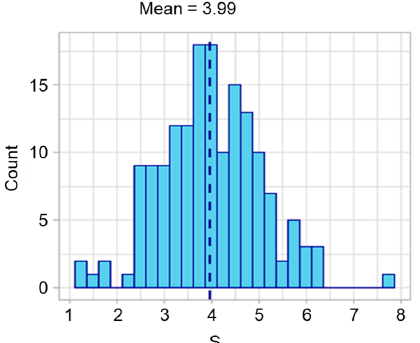
Figure 2. Distribution of S in 162 subjects. A dashed line indicates the mean of S in 162 cases with no lack of clinical information.